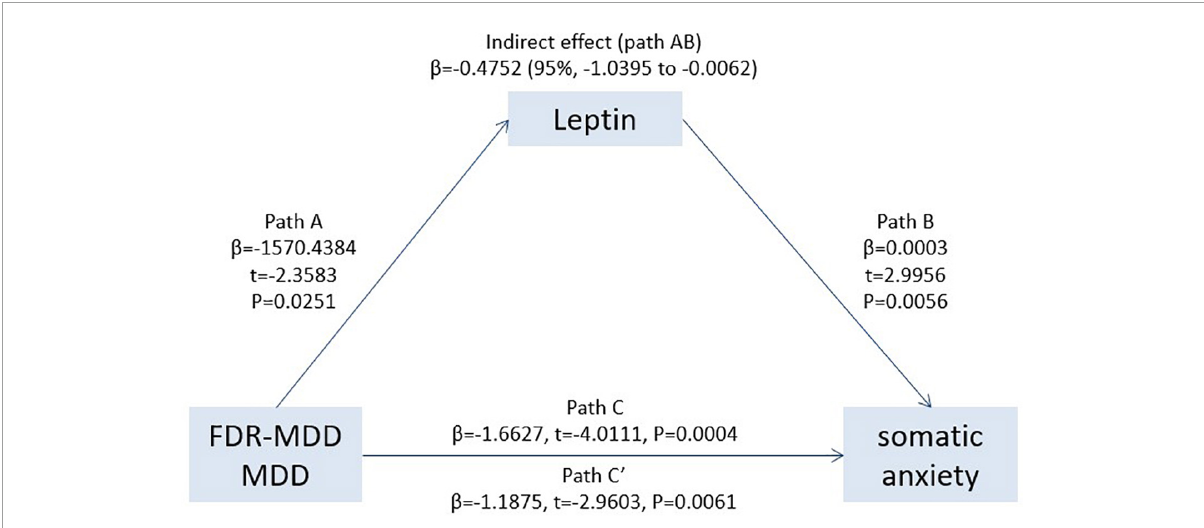
FIGURE3 Leptin significantly mediated the association between clinical status (MDD or FDR-MDD) and “somatic anxiety,” providing further evidence that there was an indirect way to influence patient “somatic anxiety” by leptin. Path C represents the variance in clinical state associated with “somatic anxiety,” and Path C (cid:48) represents the association between clinical status and “somatic anxiety” after taking into account leptin as a mediator. Path AB in the mediation effect and is significant at p < 0.05 based on confidence intervals from bias-corrected bootstrapping of 5,000